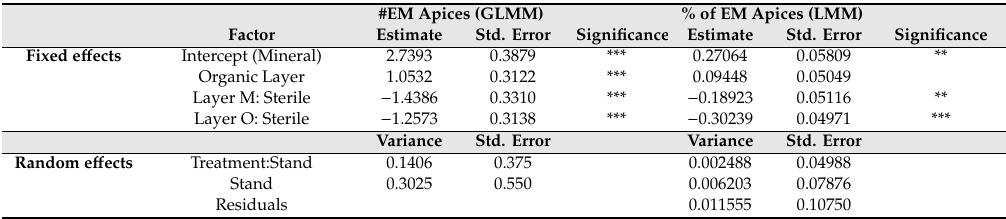
Table 1. General linear mixed e ff ect models (GLMM) and linear mixed e ff ect models (LMM) estimates for the number (#) and percent (%) of ectomycorrhizal (EM) apices. Std: standard error, p: p -value. *: p -value < 0.01, **: p -value < 0.001, ***: p -value < 0.0001. Model formula: ~Layer + Layer / Steril + (1 | Stand / Treatment).